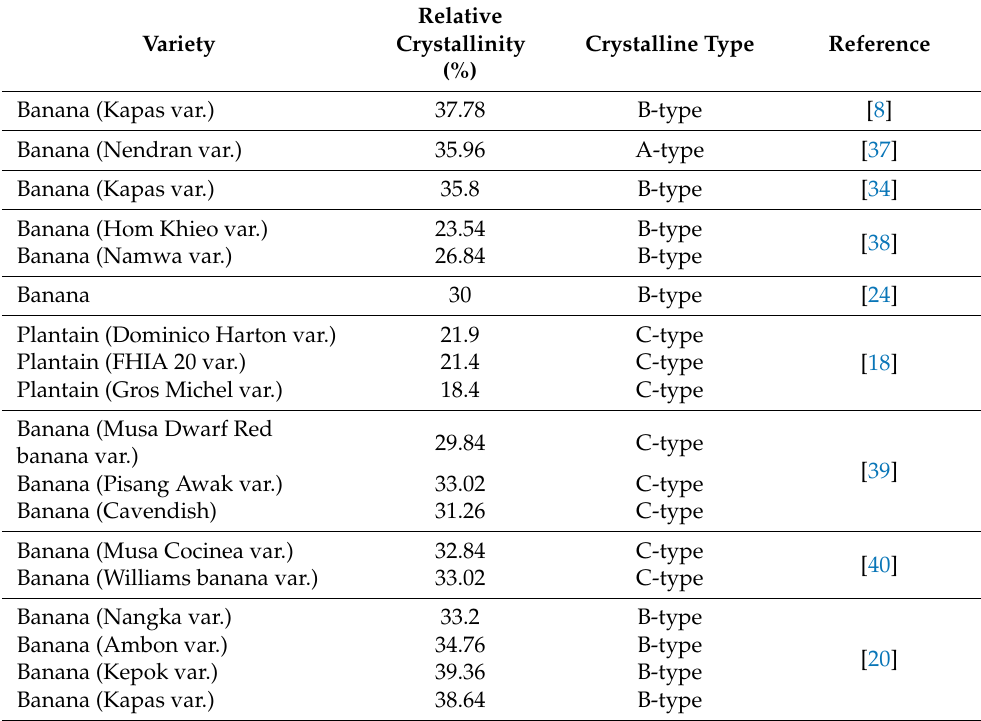
Table 2. The crystalline type and relative crystallinity of starch form various banana varieties. Variety Crystalline Type Relative Crystallinity (%)